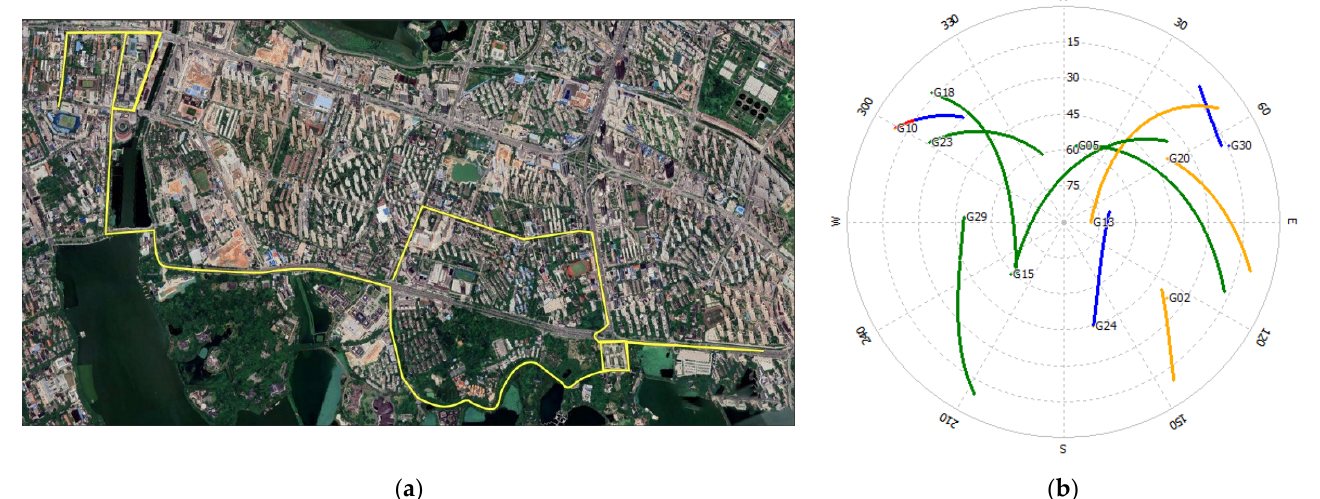
Figure 11. ( a ) The trajectory of the kinematic test; ( b ) sky plot of the kinematic